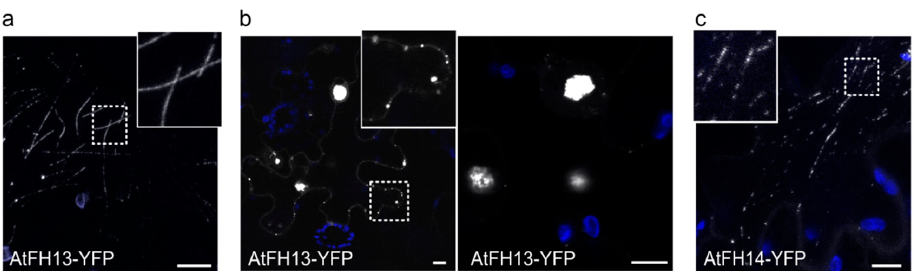
Figure 2. Localization of AtFH13-YFP and AtFH14-YFP in transiently transformed tobacco epidermis. ( a ) AtFH13-YFP localizes to fibrous structures at low expression levels. ( b ) Aggregates of overexpressed AtFH13-YFP. ( c ) Fibrous localization of AtFH14-YFP. All images are maximum intensity projections of confocal Z-stacks. YFP fluorescence is shown in grayscale, chlorophyll autofluorescence in blue. Scale bars are 10 µm, insets show the indicated details magnified 2.5 times compared to the main image. Construct abbreviations are defined in the text and in Figure 1.